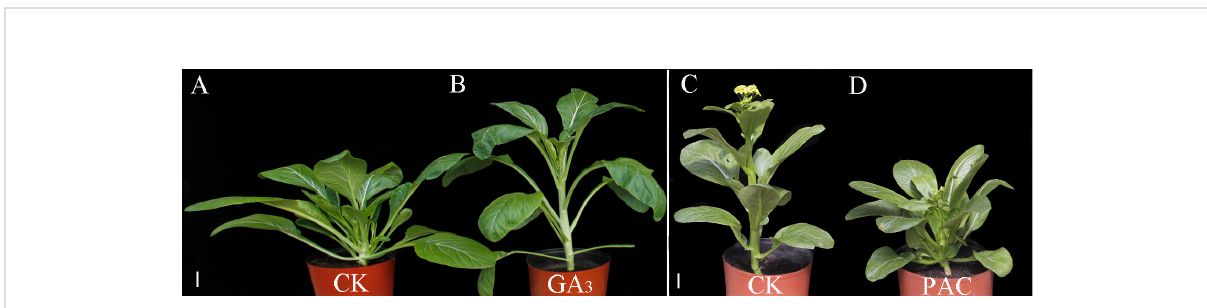
FIGURE 6 Phenotypes of CX020 and CX010 after treatments with exogenous GA 3 and PAC. (A, B) The CK and exogenous GA 3 treatment of CX020. Bar = 8 cm. (C, D) The CK and exogenous PAC treatment of CX010. Bar = 5